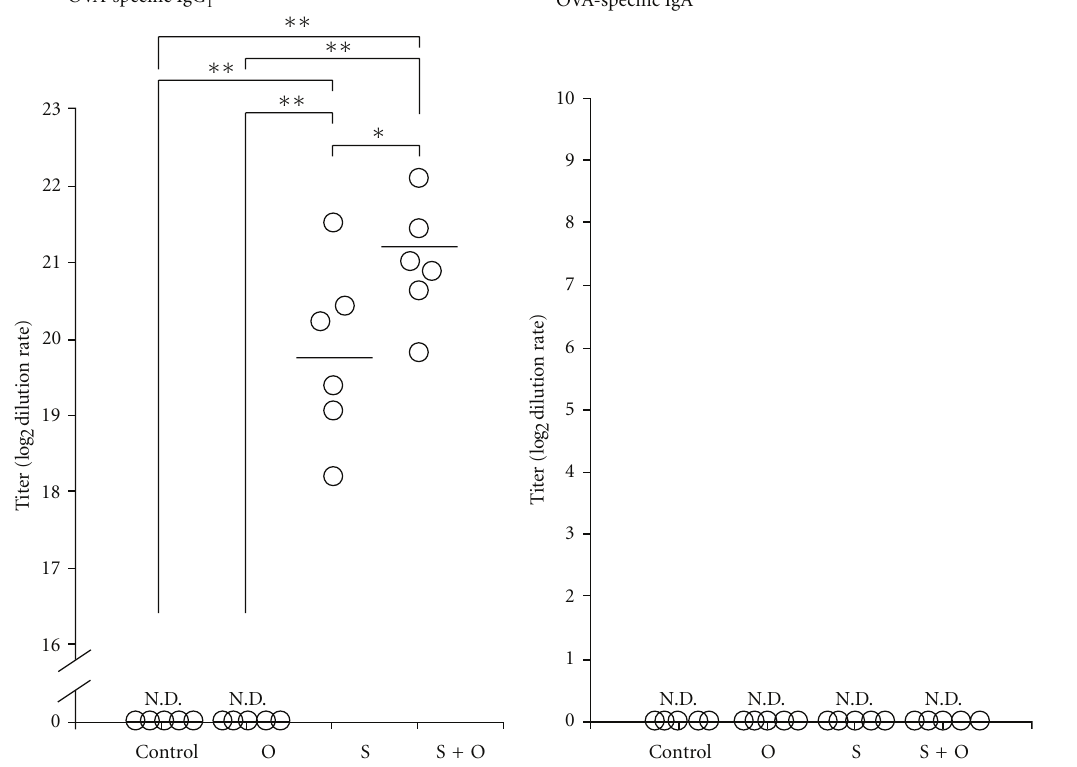
Figure 7: E ff ects of the maternal exposure to food antigens during lactation and the maternal allergic status on plasma OVA-specific IgG1 and IgA levels in o ff spring. We found OVA-specific IgG1 only in the plasma of na¨ıve o ff spring breastfed by OVA-sensitized mothers, which implies that OVA-specific IgG1 transferred from mothers circulate in their o ff spring. Plasma OVA-specific IgA levels were undetectable in the four groups of o ff spring. Data are shown as the means and individual data points. N.D.: not detectable. ∗ P < 0 . 05, ∗∗ P < 0 . 01, n =